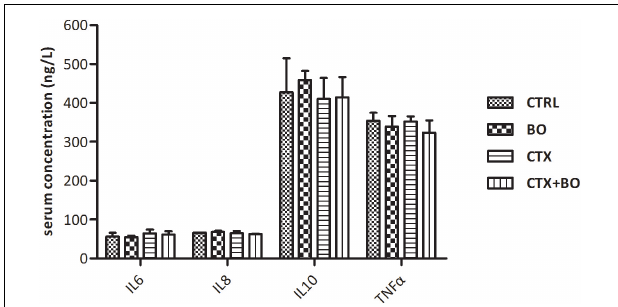
FIGURE 3 | Impact of B. ovatus ELH-B2 on the cytokine productions of immunocompetent and immunosuppressed mice. Data are displayed as mean ± SD.